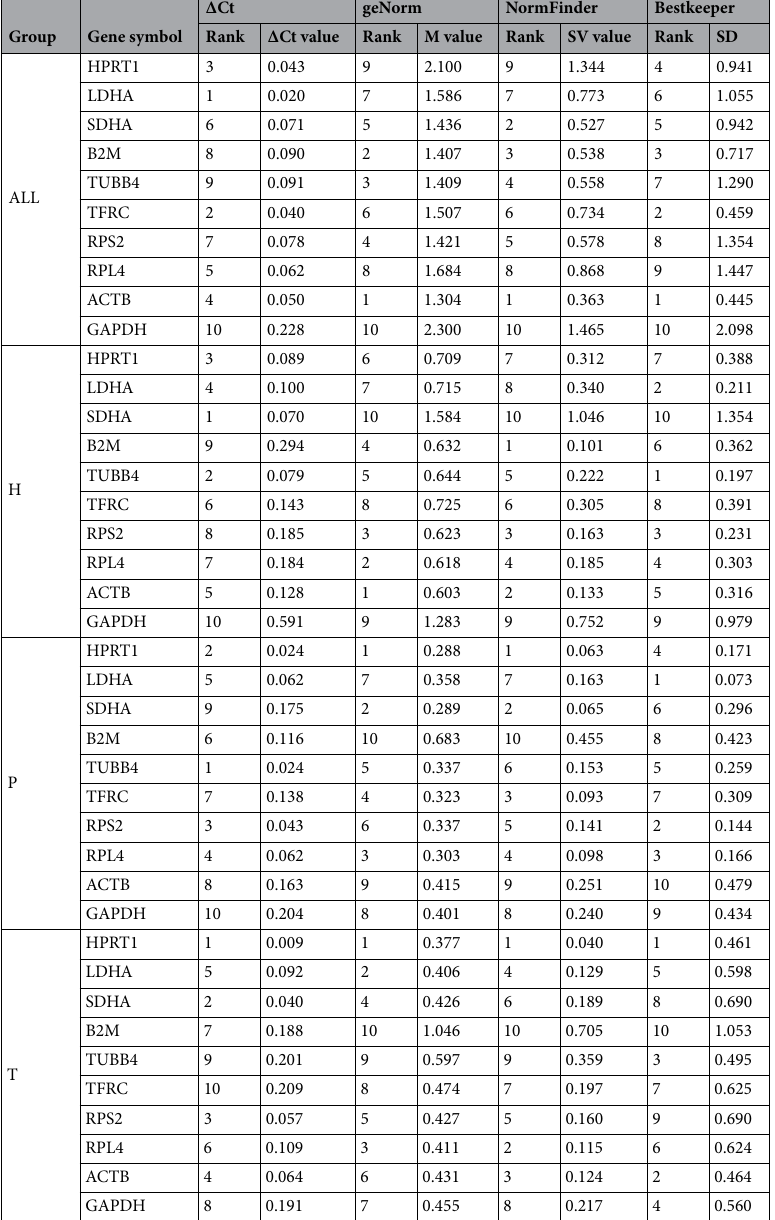
Table 2. Expression stability analysis of each candidate reference gene for the reproductive axis tissues based on ΔCt, geNorm, NormFinder and BestKeeper algorithms. H hypothalamus, P pituitary, T testis, M Average expression stability, SV Stability Value, SD Standard Deviation. With NormFinder and geNorm, low stability values indicate greater gene expression stability. With BestKeeper, genes with SD values greater than 1 are considered